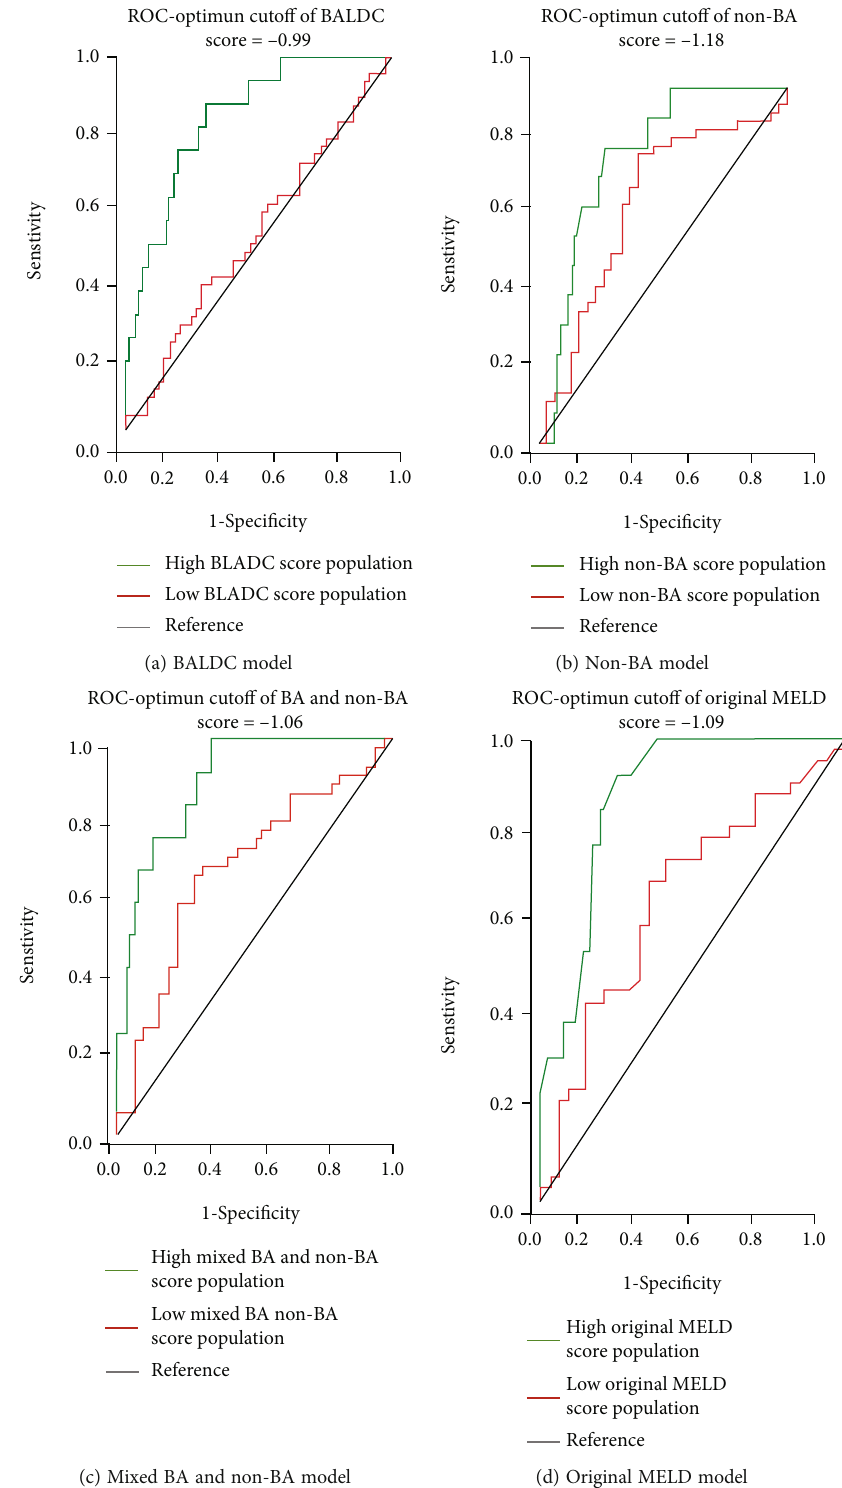
Figure 3: ROC analysis using optimum cut-o ff values in BALDC, non-BA, mixed BA and non-BA, and original MELD model